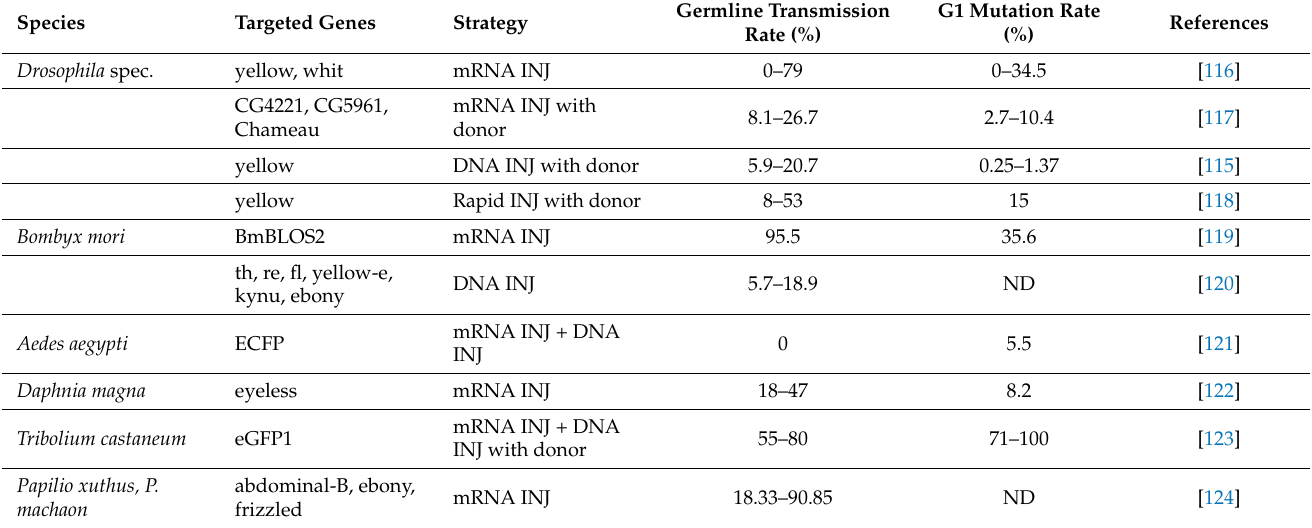
Table 9. Applications of CRISPR-Cas9 in